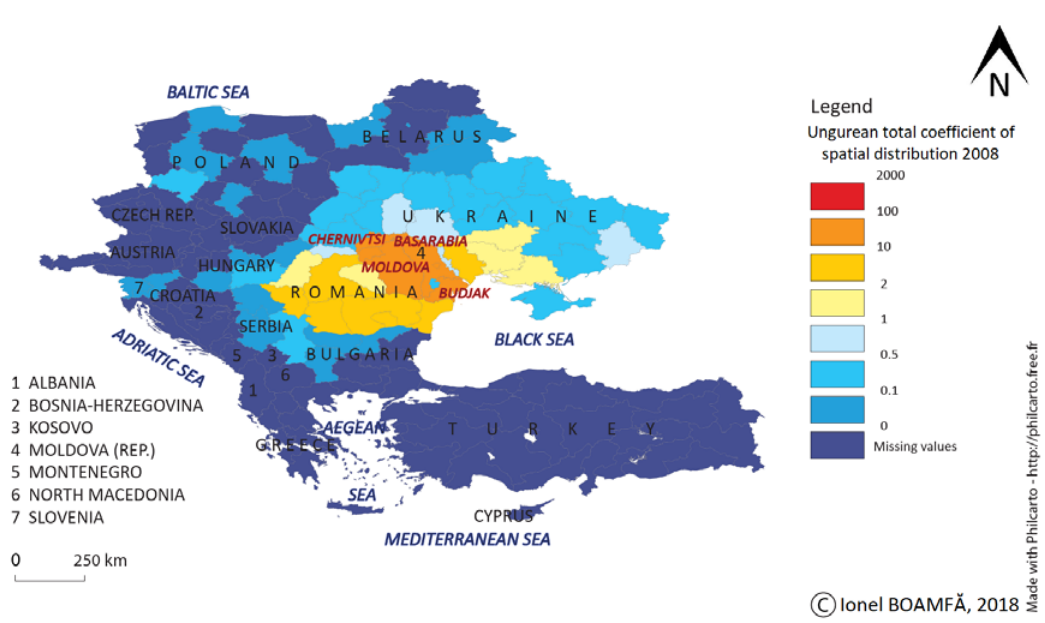
Figur e 10 . G eographical repartition of the anthroponym Ungurean. Coef. of spatial distribution